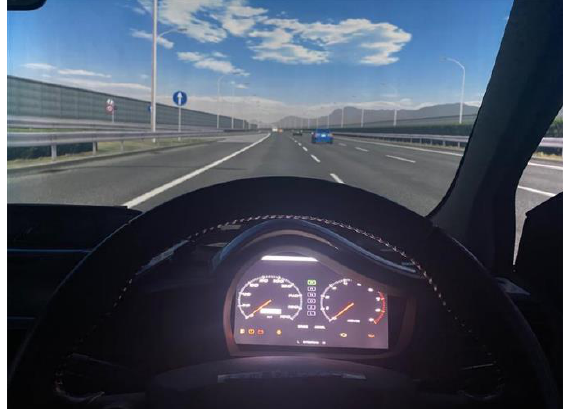
Figure 2. View from the driver ’ s seat.